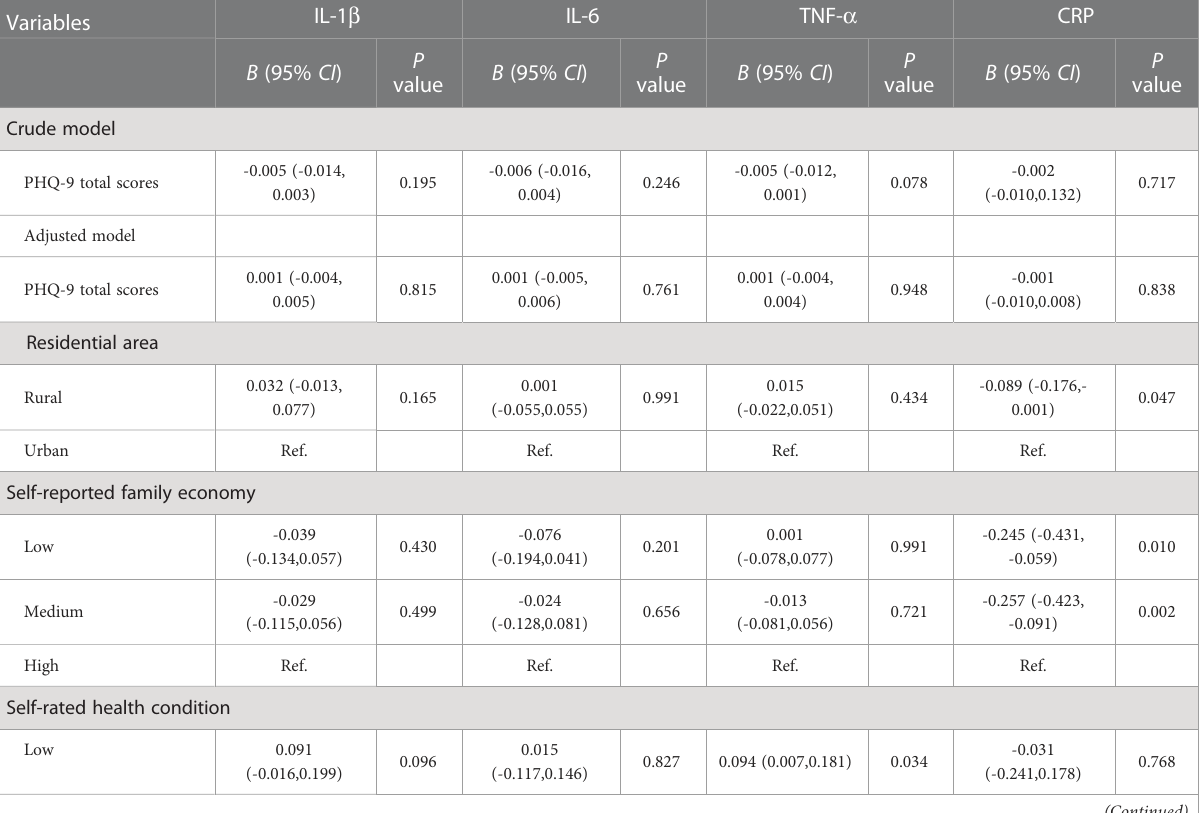
TABLE 2 Generalized linear models of the associations between PHQ-9 total scores and in fl ammatory biomarkers at baseline (n=723).